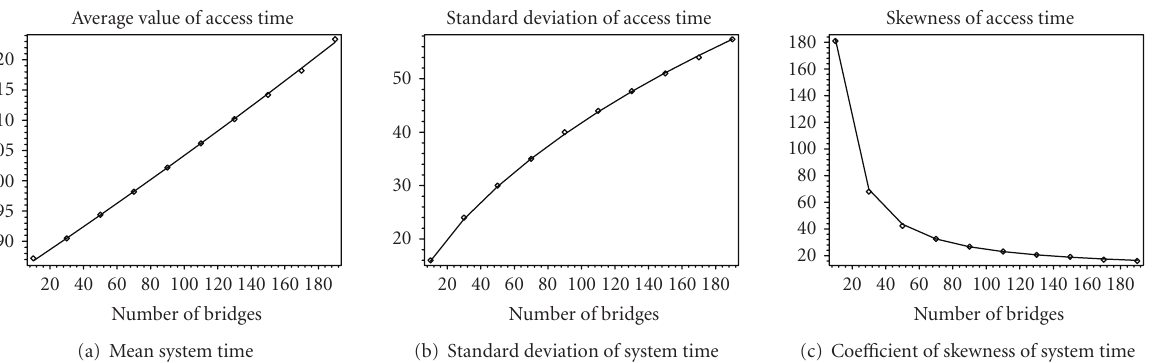
Figure 8: Moments of system (access) time. Analytical results are shown as lines, and simulation results are shown as